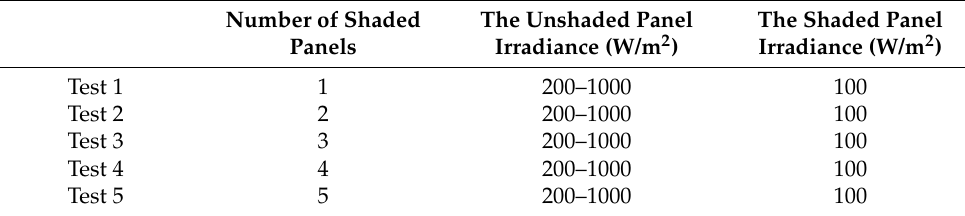
Table 2. Tests applied to the simulation set-up.